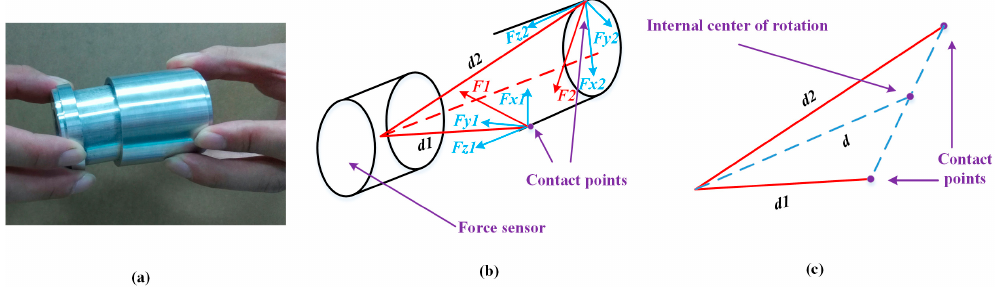
Figure 10. Inside of the two-point contact model: ( a ) contact situation; ( b ) force analysis and contact of rotation; ( c ) center of rotation.